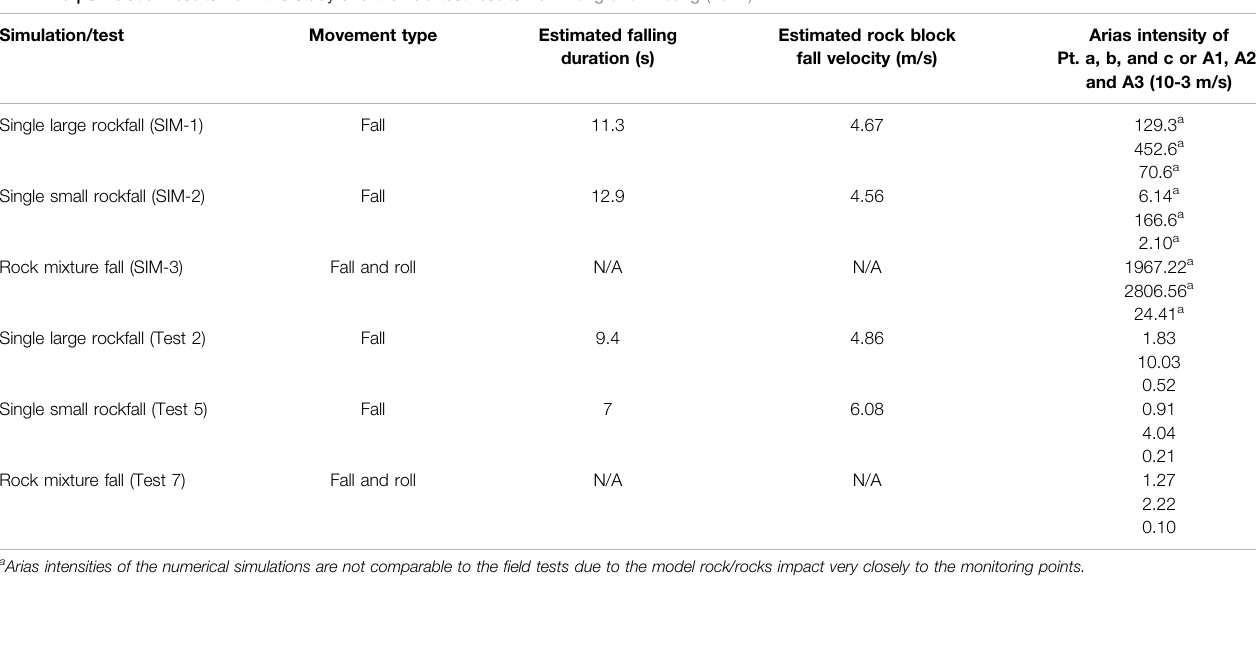
Frontiers in Earth Science |